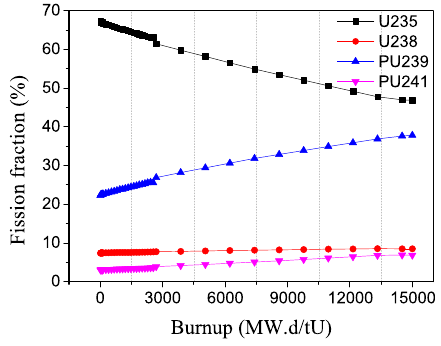
Figure 1. Fission fraction of the four isotopes vs fuel